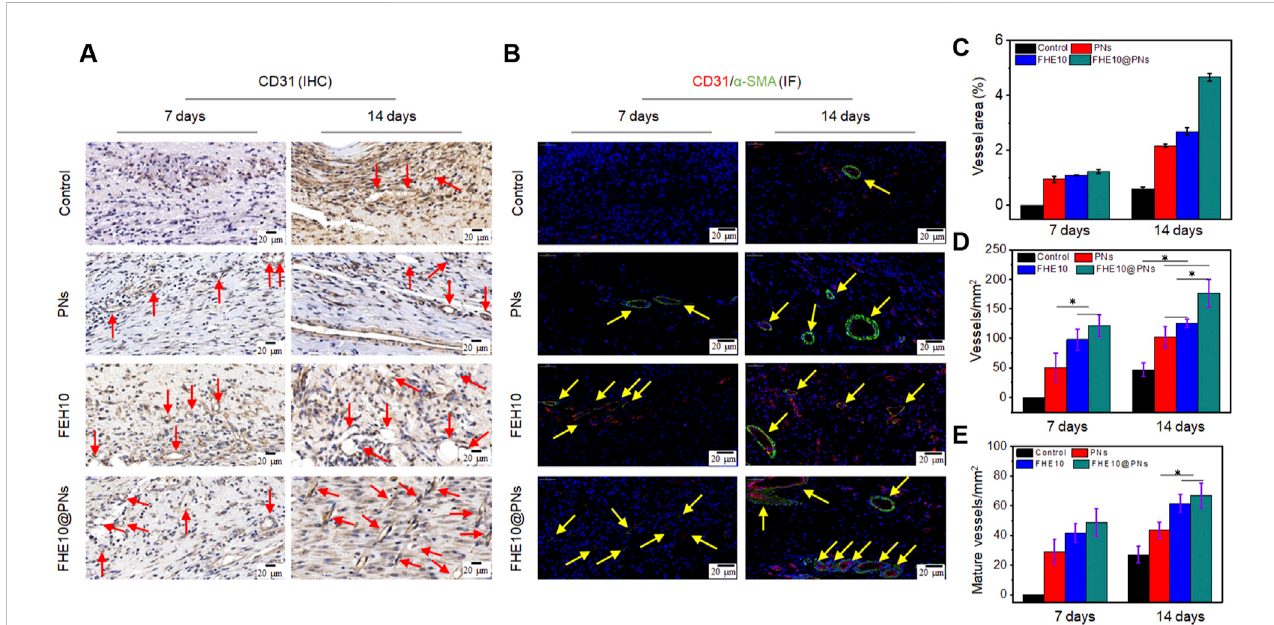
FIGURE 6 IHC and IF analysis of neovascularization in wound of control, PNs, FHE10, and FHE10@PNs groups, respectively. (A) IHC staining for CD31, red arrows mean newly formed blood vessels; (B) IF co-staining for α -SMA and CD31, yellow arrows mean mature vessels; (C) Area analysis of mature blood vessels at 7 and 14 days post-operation; (D) Quantitative analysis of newly formed blood vessels at 7 and 14 days post-operation; (E) Quantitative analysis of mature vessels at 7 and 14 days